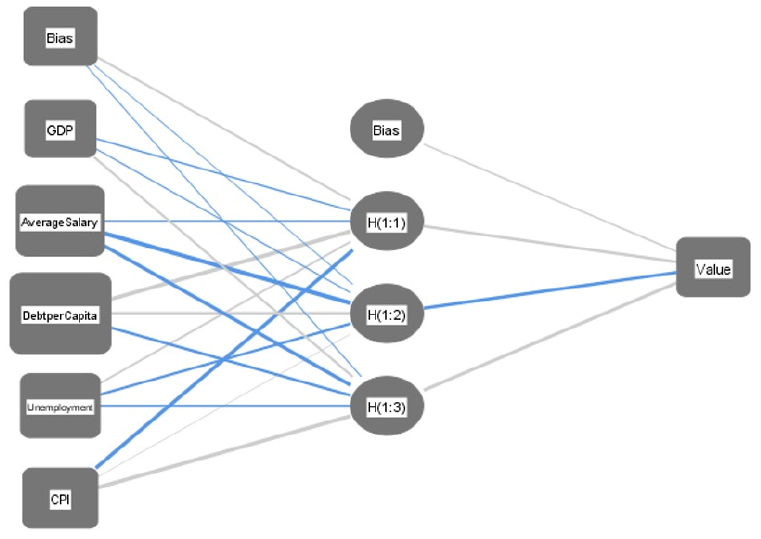
Figure 5. Artificial Neural Network Value.